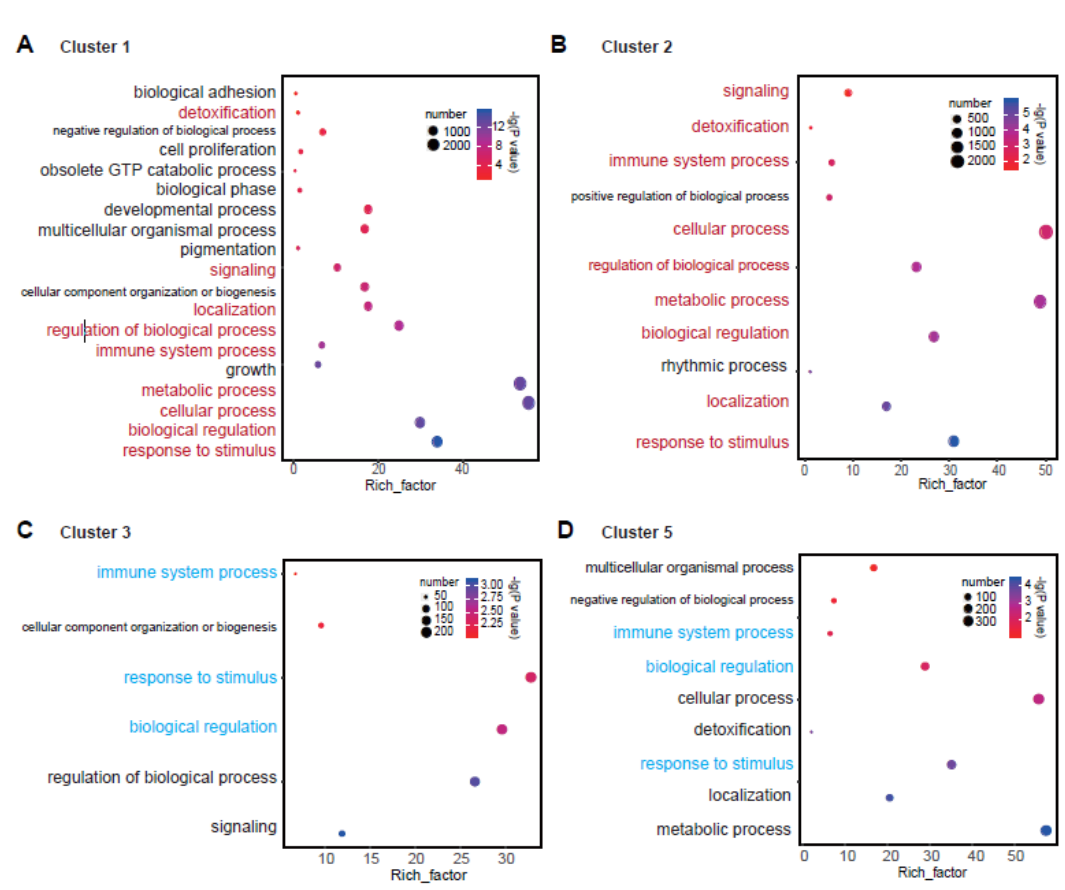
Figure 3. The corresponding biological function for clusters 1–3 and 5. ( A ) Gene ontology (GO) term for cluster 1. ( B ) GO term for cluster 2. ( C ) GO term for cluster 3. ( D ) GO term for cluster 5. The same GO terms between clusters 1 and 2 are marked in red. The same GO terms between clusters 3 and 5 are marked in cyan. The size of the circle represents the number of genes. The color of the circle represents the enriched p -value, which was converted to –lg ( p -value). The x axis is the value of the Rich factor. The Rich factor is the proportion of enriched genes to DEGs.